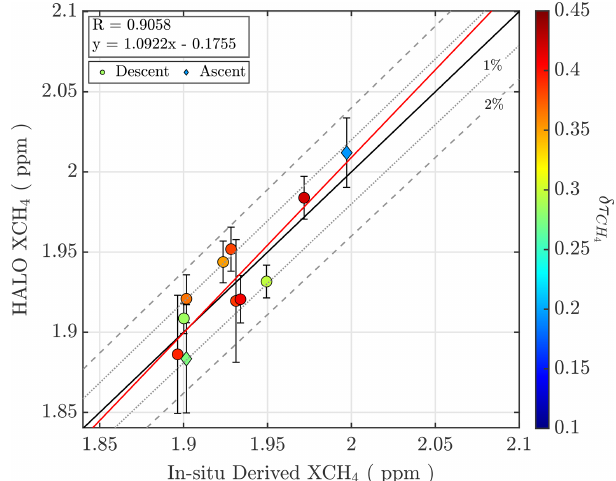
Figure 11. Comparison of the in situ-derived XCH 4 to HALO XCH 4 for 11 spirals, color coded by the HALO one-way DAOD. A correlation between in situ-derived and HALO XCH 4 gives R = 0 . 9058, with the fit shown as a red dashed line against the black one-to-one line. The 1% and 2% error bounds are shown. The 1 σ error bars are shown for the HALO XCH 4